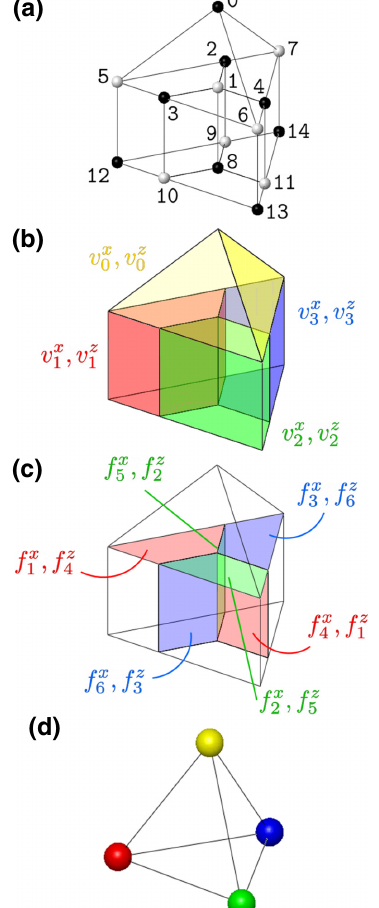
FIG. 2. The 3D color code of distance 3. In (a), qubits are rep- resented by vertices. Note that the set of qubits are bipartite, as displayed by black and white colors. Stabilizer generators and gauge generators of the code are illustrated by volume operators in (b) and face operators in (c), respectively. The dual lattice of the code is shown in